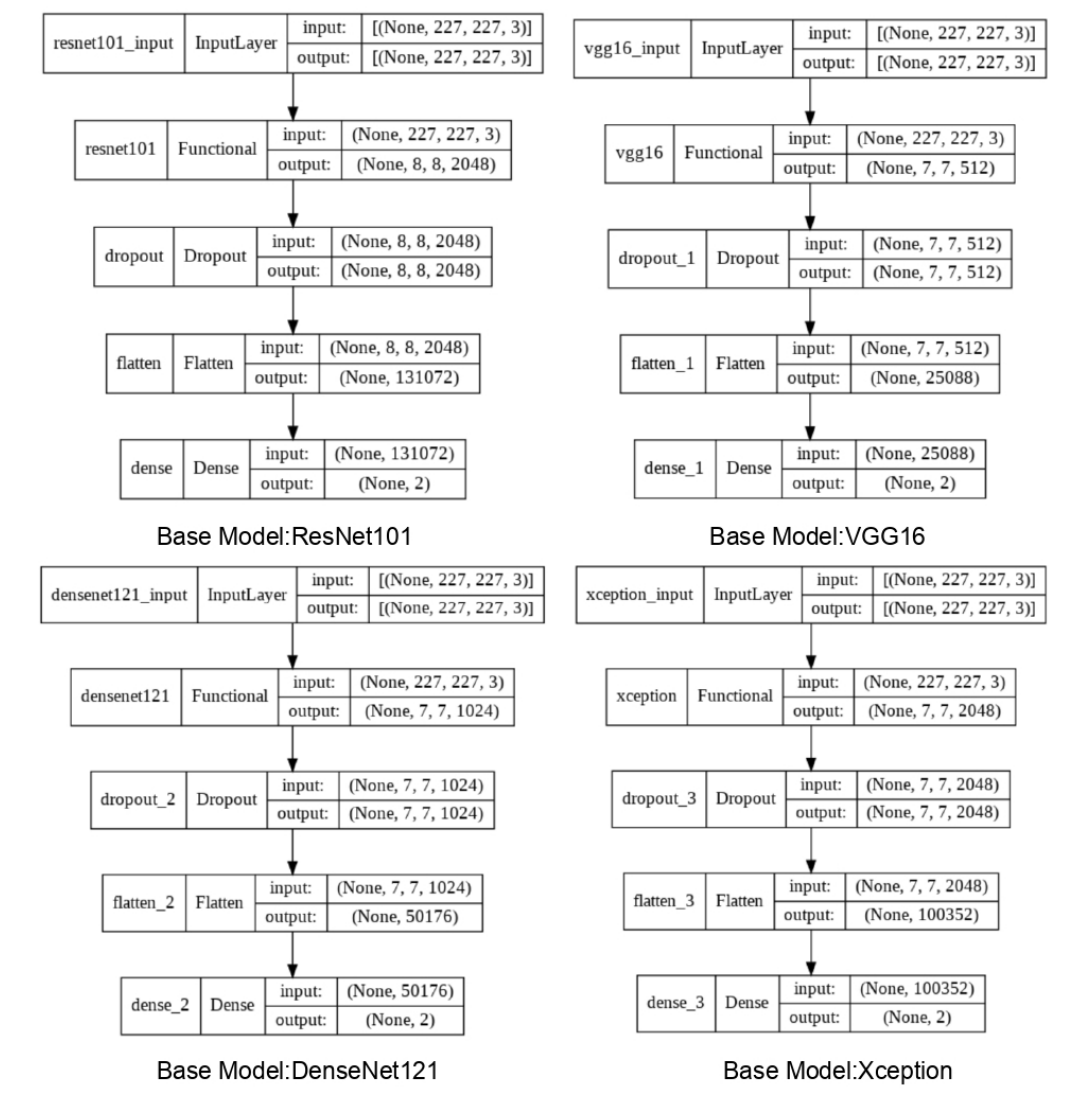
Figure 8. Model summary for different DNN